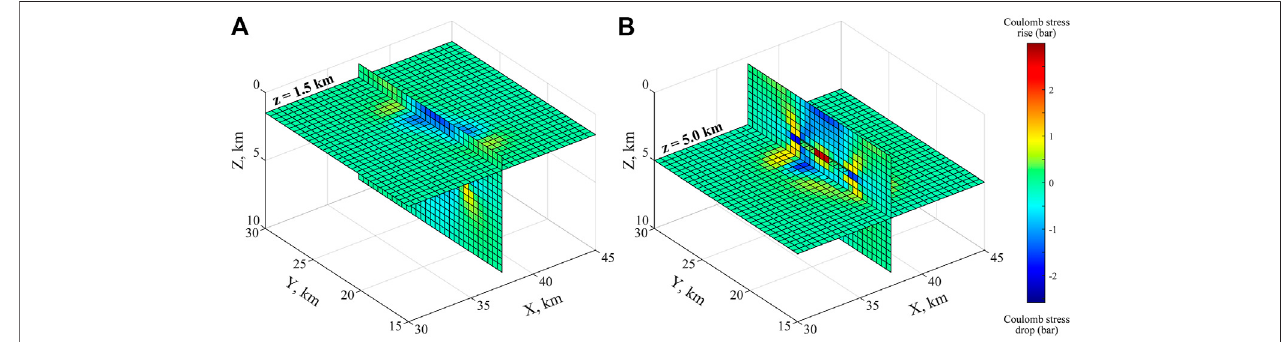
FIGURE11| Coulombstresschange(bar)calculatedonfaultpanesoptimallyorientedforfailure,consideringasthesourceofdeformationthecontractionofasub- horizontal dike located at ∼ 4 km depth. Both plots show a vertical cross section in the NS direction, crossed by horizontal layers located at (A) 1.5 km and (B) 5.0 km below the surface. (Stress fi eld generated with Coulomb3, Lin and Stein, 2004; Toda et al., 2005) using the following parameter values: i) Poisson ratio 0.25; ii) Young ’ s > S (cid:1) 50 × S (cid:1) 10 × S modulus (cid:1) 8.0 × 10 5 bar;iii)frictioncoef fi cient (cid:1) 0.7;iv)regionalstresstensor: S V > S H H min ,withvaluesscaledas: S V H min ; S H max H min (oriented max in the direction NNW-SSE); and S H oriented in direction min